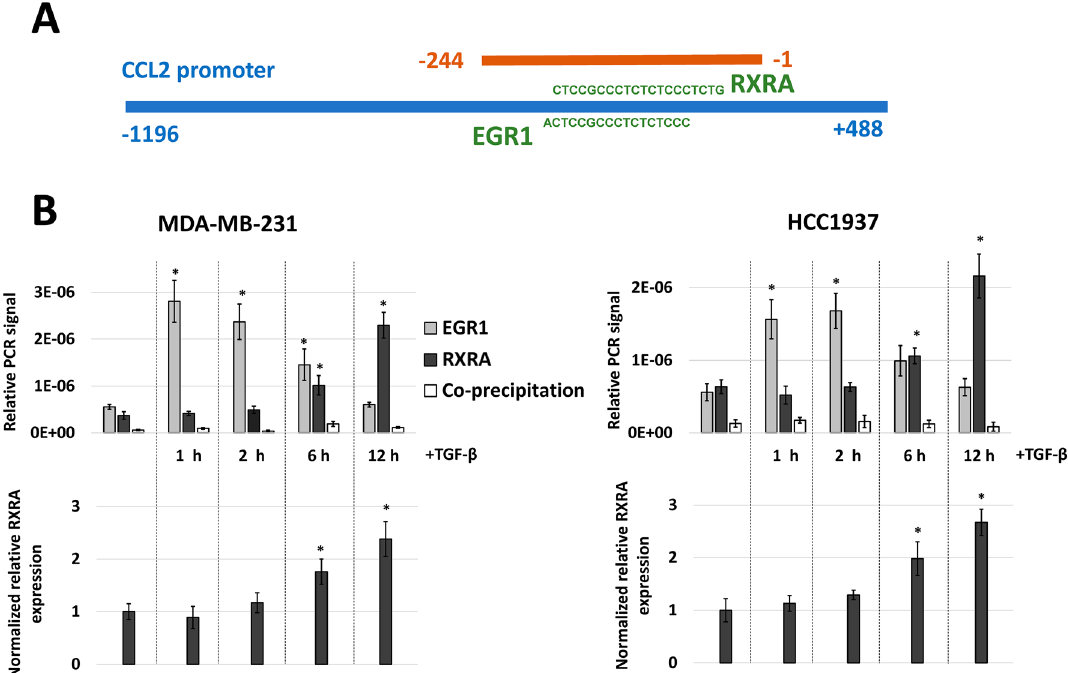
Figure 5. TGF-β1 induces EGR1 and RXRA binding to the CCL2 promoter in MDA-MB-231 and HCC1937 breast cancer cells in time-dependent manner. ( A ) Map of the CCL2 promoter, predicted EGR1-/RXRA- to the amplicon containing corresponding consensus sites (top panel). As described Material and Methods, none of the specificity controls produced signals above background. TGF-β1 also induced RXRA